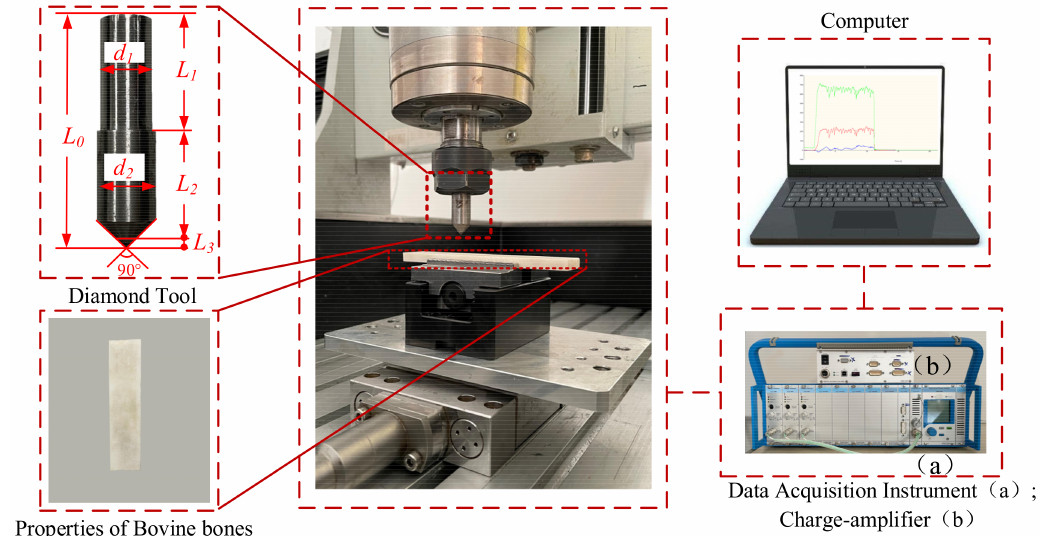
Figure 2. Experimental